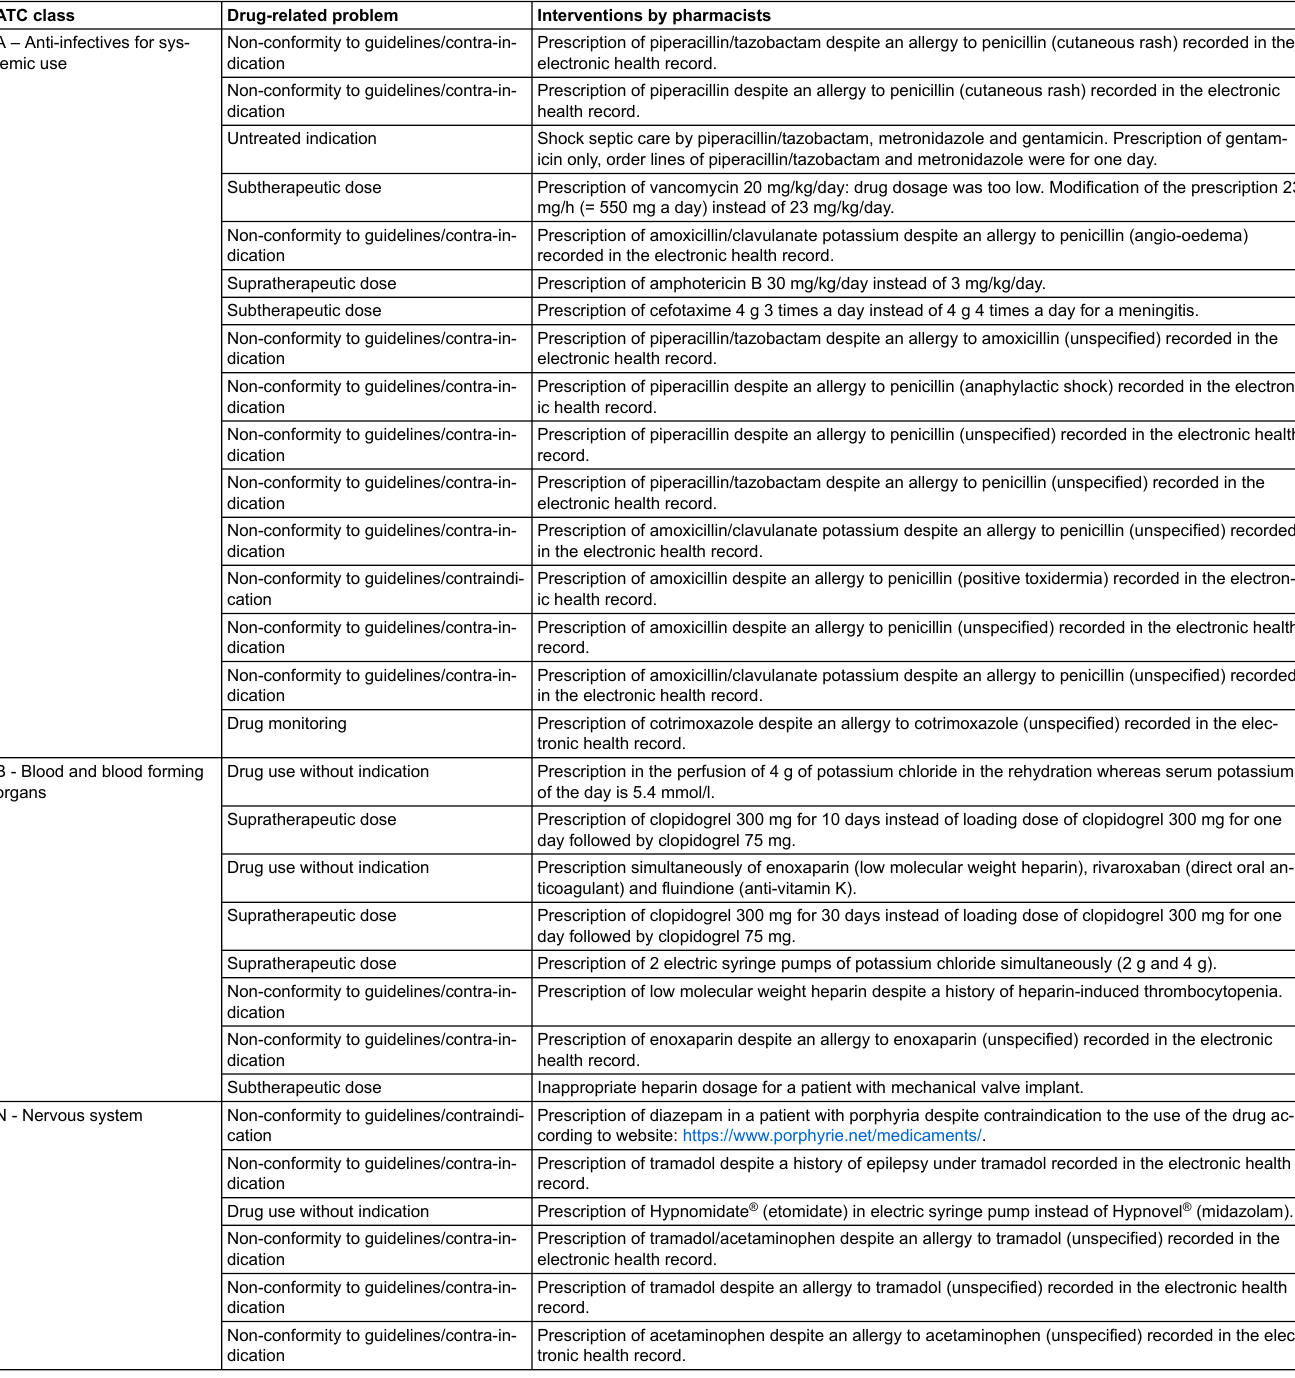
Table S2: Description of the interventions concerning prescriptions rated as ‘life-threatening’ for the three main ATC classes concerned. ATC